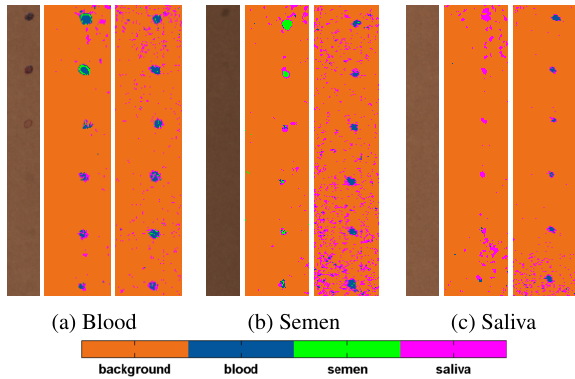
Figure 5: Results of multiclass classification. Columns for each specimen: Left - RGB. Middle - RF. Right - PCA and LDA fol- lowed by ML. Meaning of colours given in the colour bar. (Best viewed in colour.)